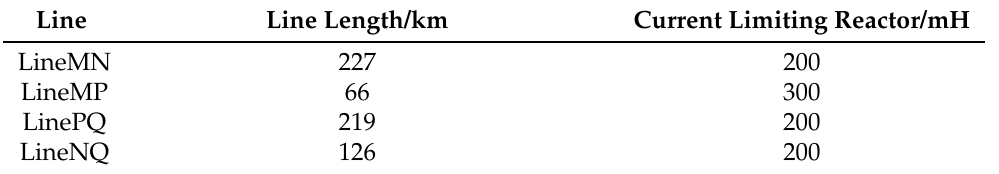
Table 2. Line Parameters.